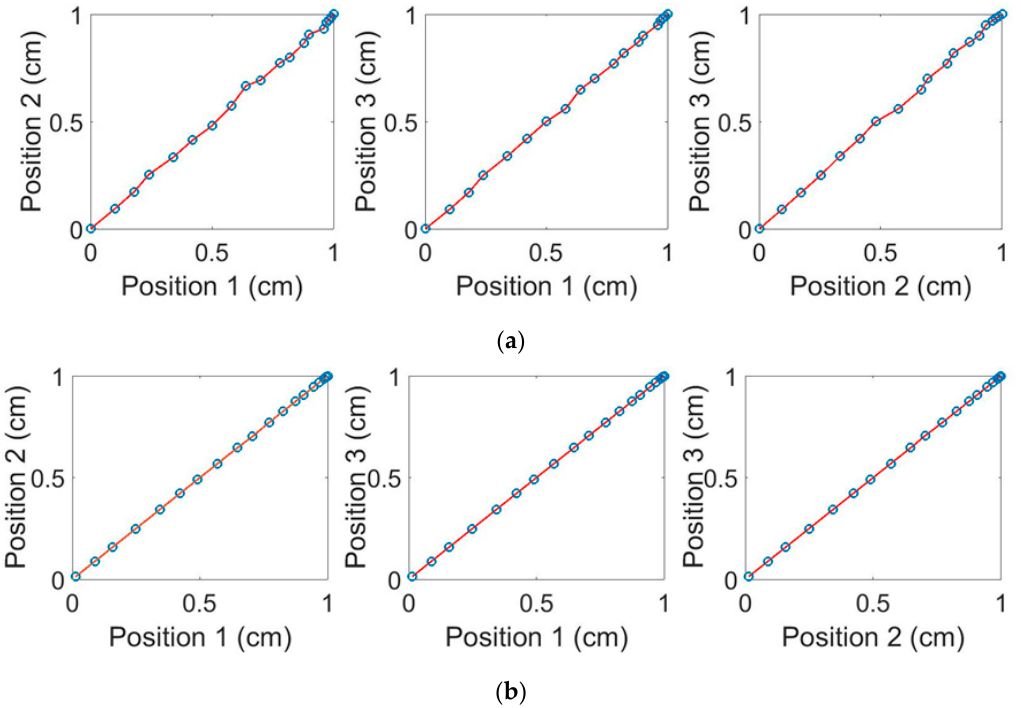
Figure 9. Normalized displacements (a) manual and (b) accelerometry.